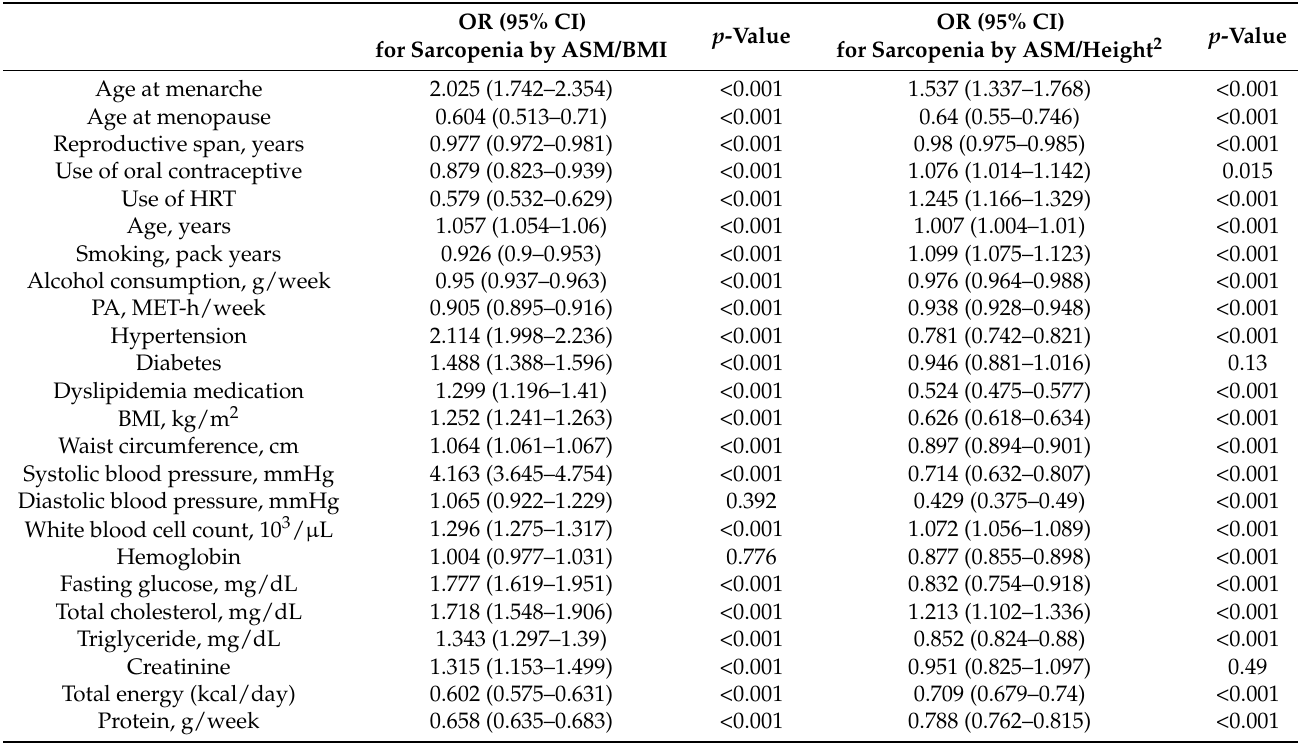
Table 2. Binary logistic regression results for covariates of sarcopenia.